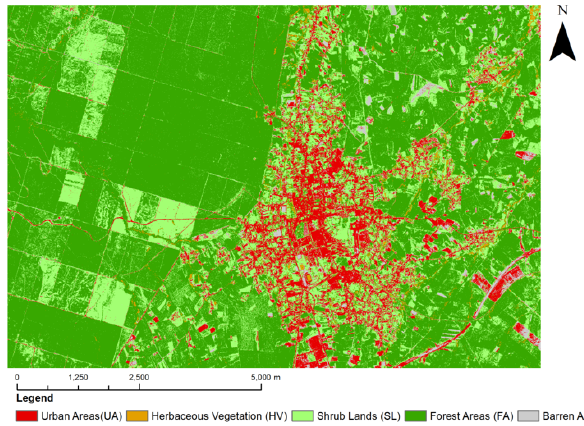
Figure 2. Hardened classification of the multispectral image presented in Figure 2, obtained assigning to each pixel the class corresponding to the maximum posterior